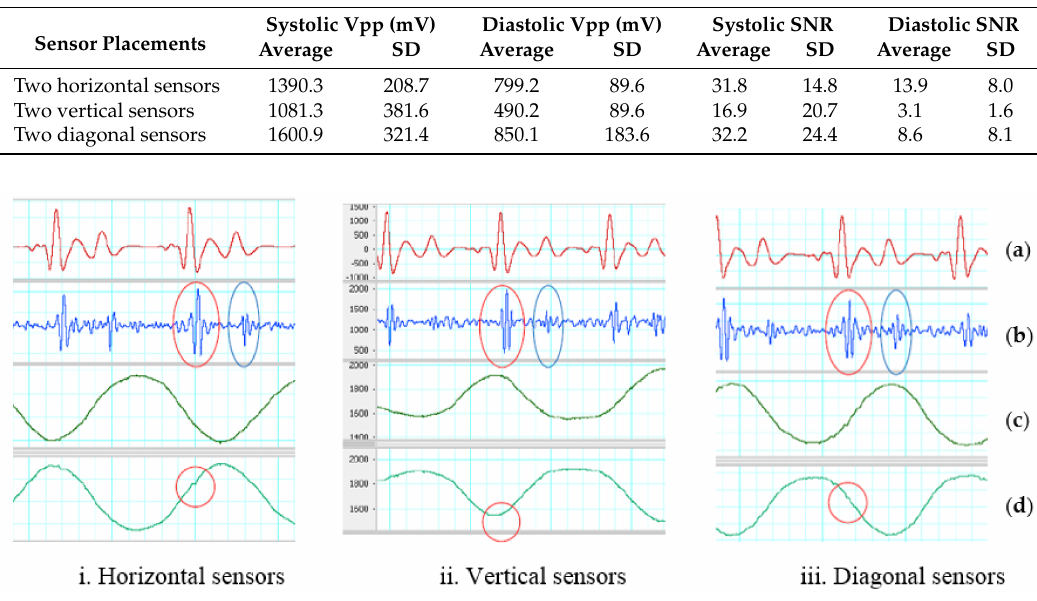
Table 3. Signal measurements of using two sensors with ADDER on gentle motion.